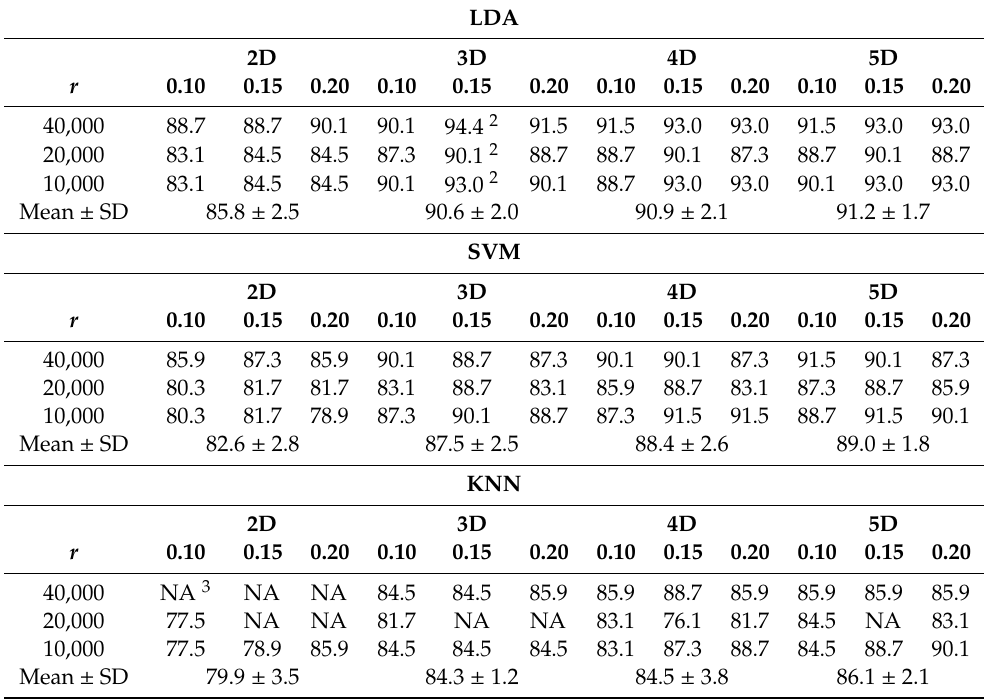
Table 3. Discrimination accuracy between older NSR and CHF participants using LDA, SVM, and KNN. LDA 2D 3D 4D 5D